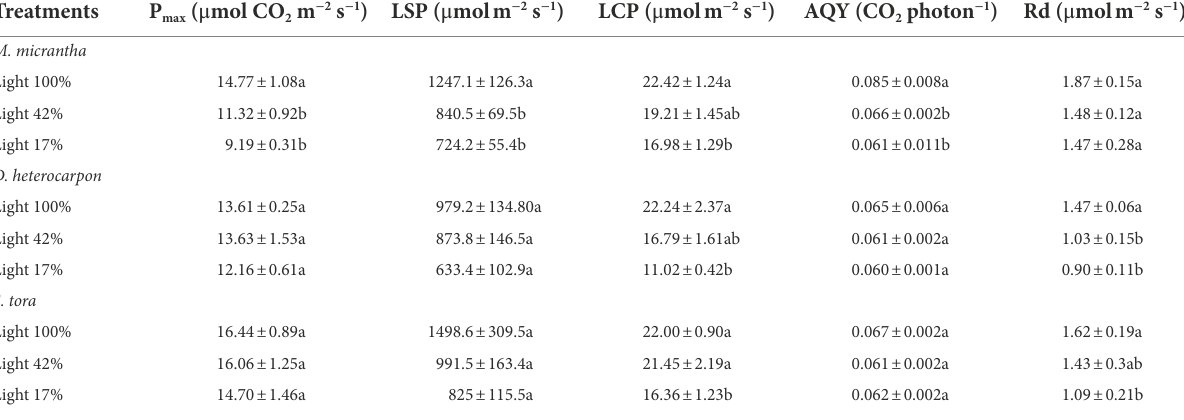
TABLE 1 Changes of photosynthetic parameters under different light conditions (average ± SE, n = 4). Treatments